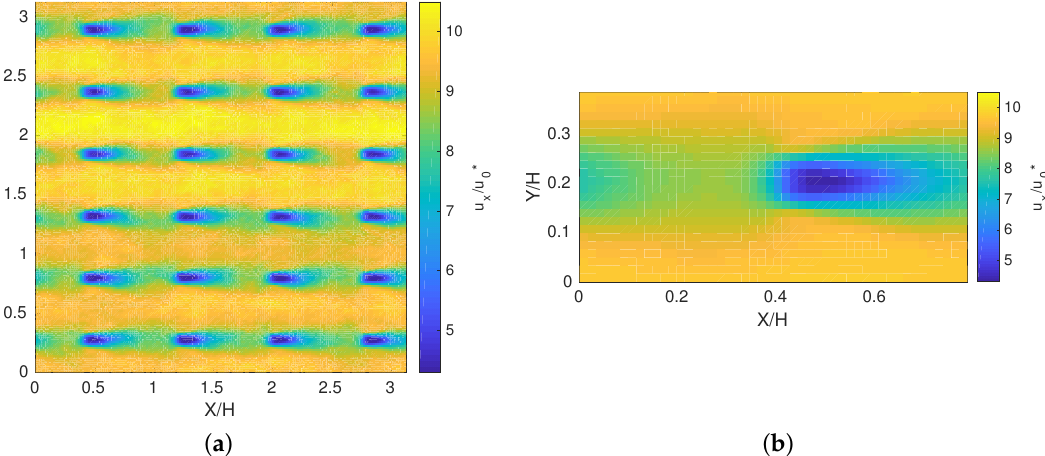
= 1.33. The velocity is T